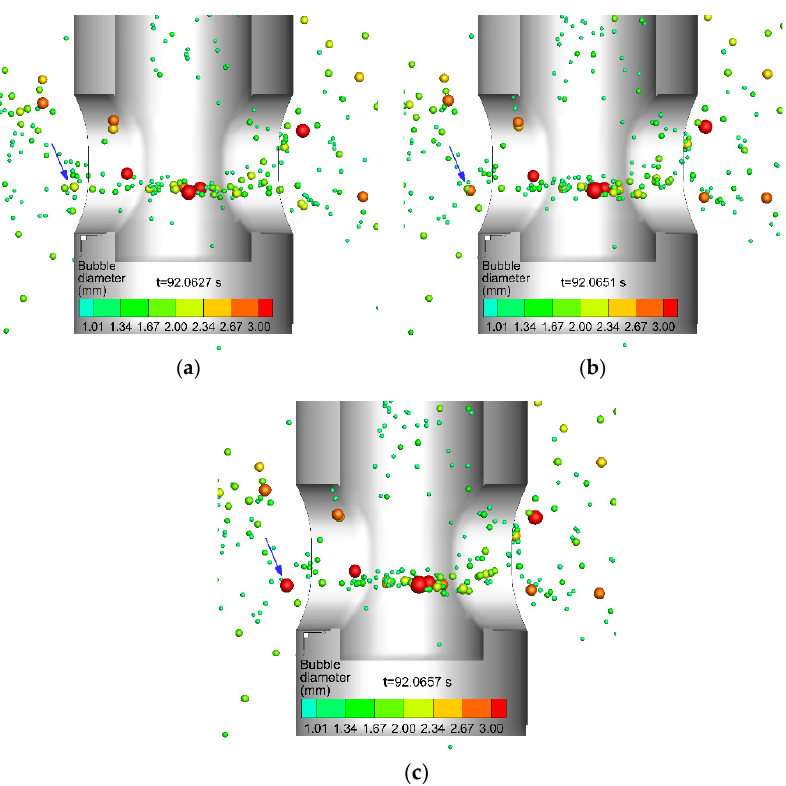
Figure 6. The typical process of the coalescence of bubbles (marked by a blue arrow), ( a ) t = 92.0627 s, ( b ) t = 92.0651 s, and ( c ) t = 92.0657 s.